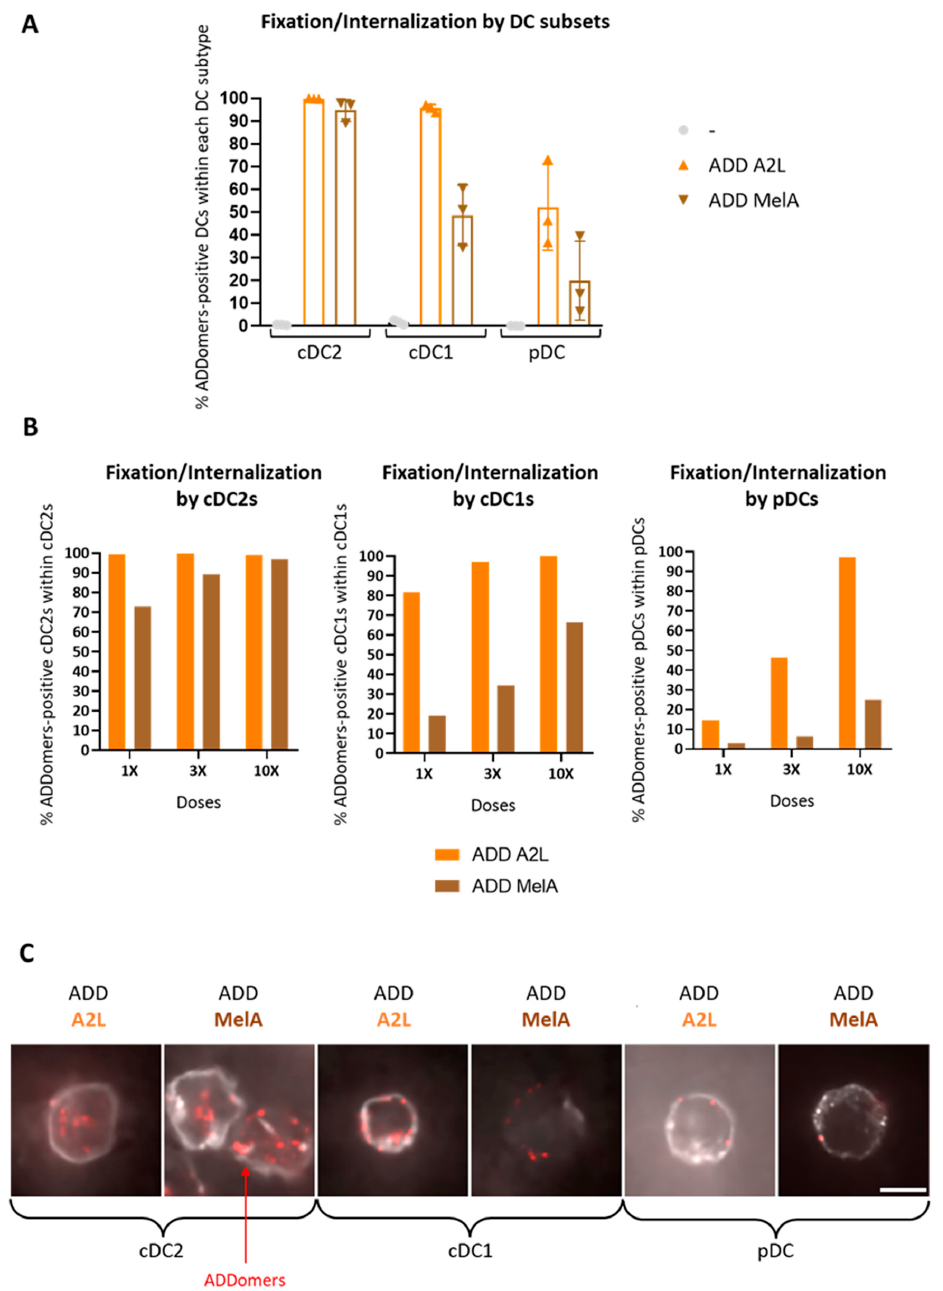
Figure 2. DC subsets efficiently fix and internalize ADDomers. PBMC ( A , B ) or PanDC ( C ) were incubated with different doses (1×, 3×, 10×) of fluorescent A2L/MelA-ADDomer for 1 h ( A , B ) or 2 h ( C ). The fixation and internalization of ADDomer by DC subsets were then evaluated by flow cytometry and confocal microscopy. ( A ) Percentage of fixation of ADDomer (3×) by each DC subset ( n = 3 donors). ( B ) Dose response of ADDomer fixation by DC subsets ( n = 1 donor). ( C ) Confocal imaging of ADDomer internalization by DC subsets. ADDomers are colored in red and the specific underlying BDCA1, BDCA2 or BDCA3 labeling is shown in gray. Scale bar is 5 microns and images are 18 × 18 microns.